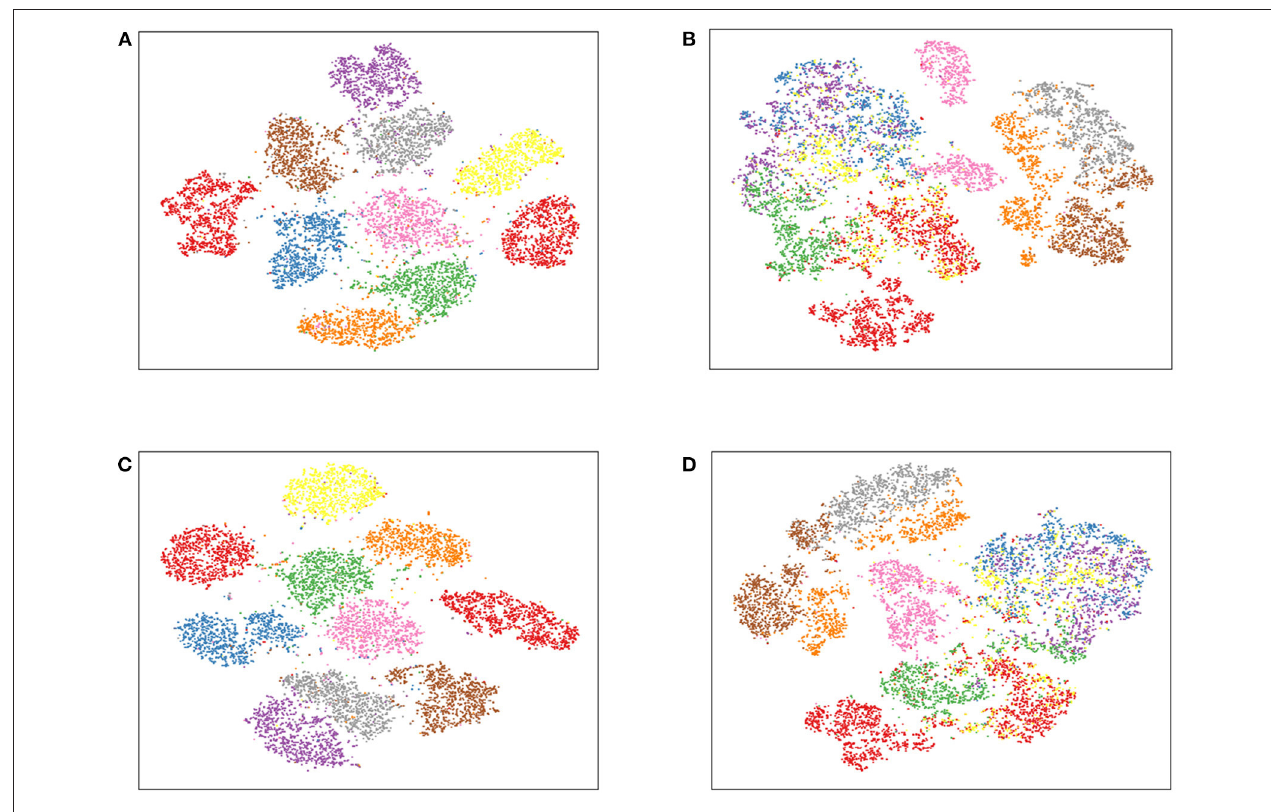
FIGURE 2 | The t-SNE figures of DDNMF and AE1 on MNIST and FashionMNIST. (A) DDNMF + MNIST, (B) DDNMF + FashionMNIST, (C) AE1 + MNIST, (D) AE1 +